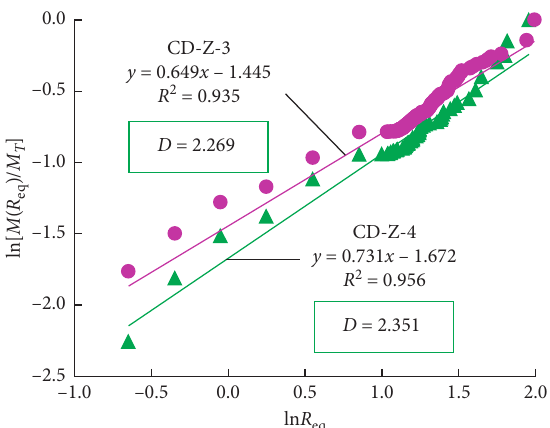
Figure 7: Calculation of fractal dimensions under different dis- turbance amplitude Δ σ .